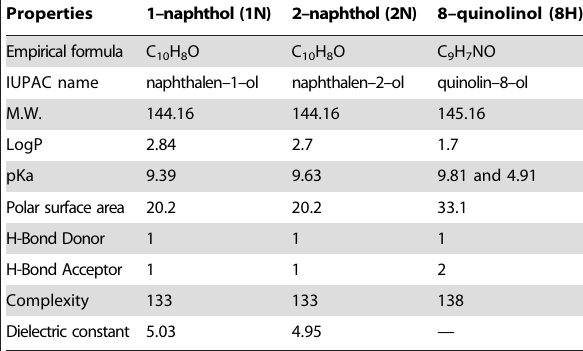
Table 1. Physicochemical properties of pollutants.